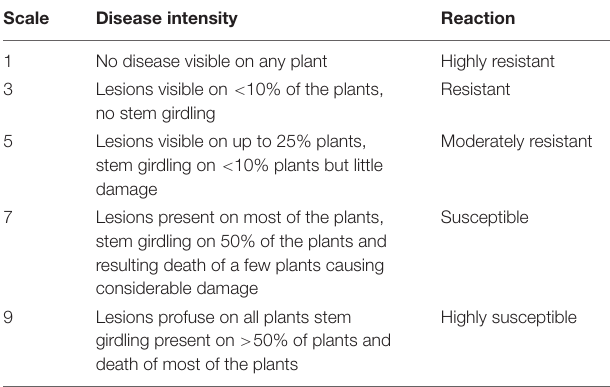
TABLE 1 | Disease rating scale for Ascochyta blight (AB) in